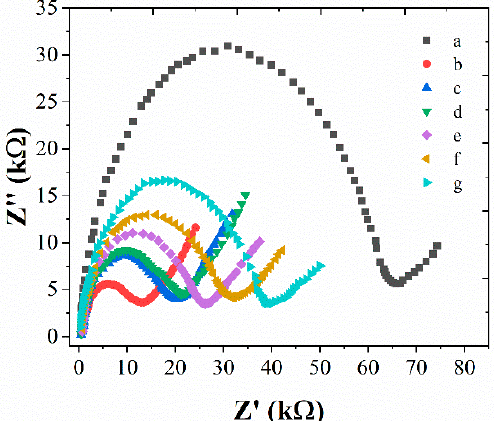
Figure 4. EISs of ( a ) bare glassy carbon electrode (GCE); ( b ) Au/GCE; ( c ) anti- L. brevis/ Au/GCE; ( d ) ILs/anti- L. brevis/ Au/GCE; ( e ) BSA/ILs/anti- L. brevis/ Au/GCE; ( f ) L. brevis/ BSA/ILs/anti- L. brevis/ Au/GCE; ( g ) HRP-anti- L. brevis/L. brevis/ BSA/ILs/anti- L. brevis/ Au/GCE in 5 mM [Fe(CN 6 )] 3 − /4 − .